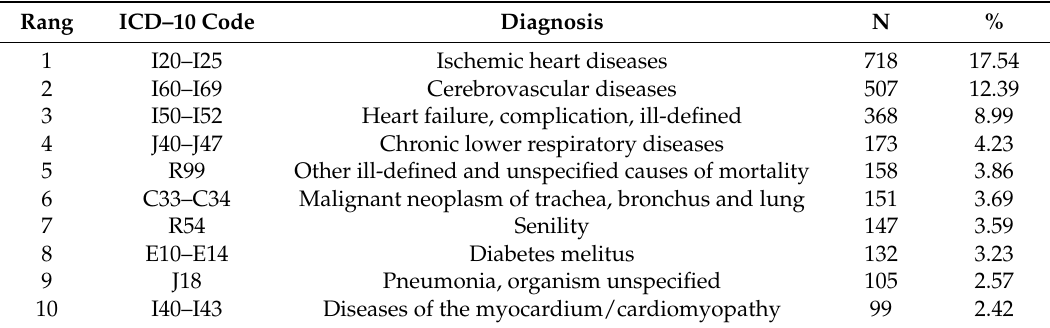
Table 5. Ranking and share of 10 leading causes of death in the town of Mali Lošinj